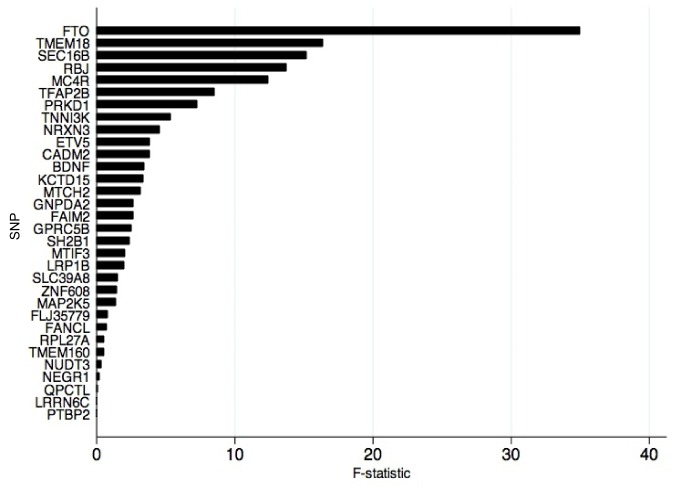
Strength of individual genetic variants for BMI as genetic instruments in instrumental variable analysis.
F-statistic derived from first-stage regression in two-stage least squares analysis where each of the 32 alleles was used as an individual instrument for BMI.